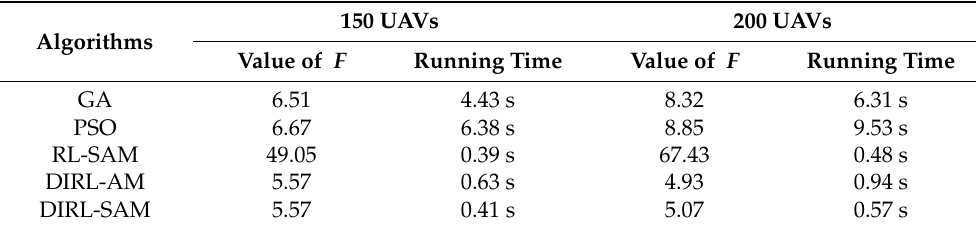
Table 7. Compared results of different methods in different numbers of UAVs.